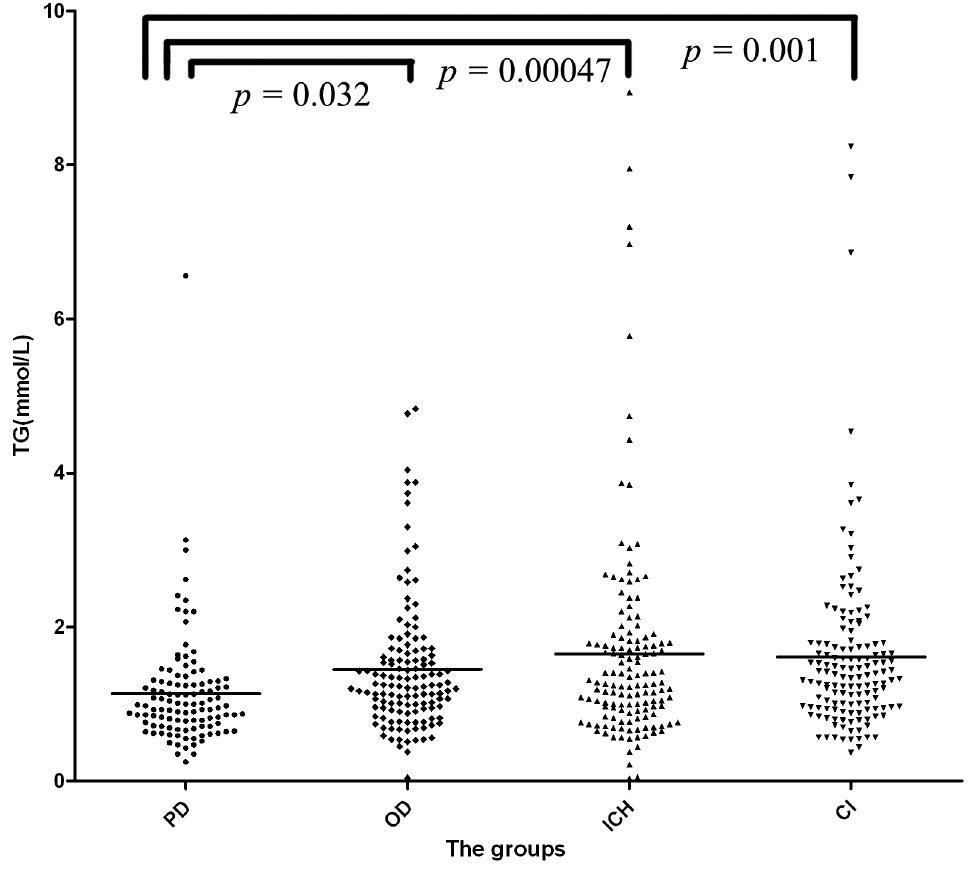
Figure 1. The serum level of triglyceride (TG) in the four groups. PD group had a significantly lower serum level of triglyceride (TG) than the OD ( p =0.032), ICH ( p =0.00047) and CI ( p =0.001)